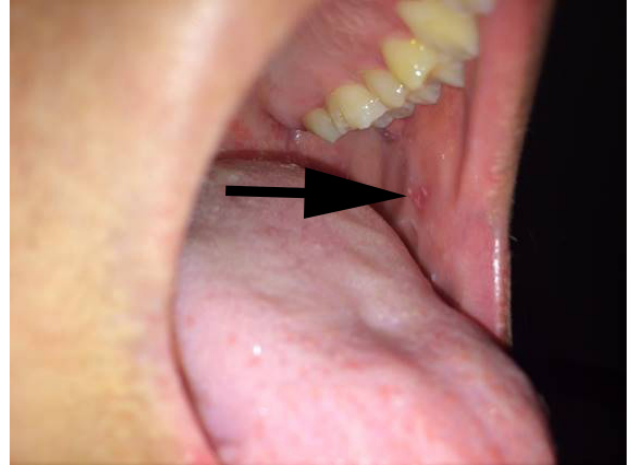
Figure 2. Koplik spots. Photo used with permission of Michael J. Burns, MD.